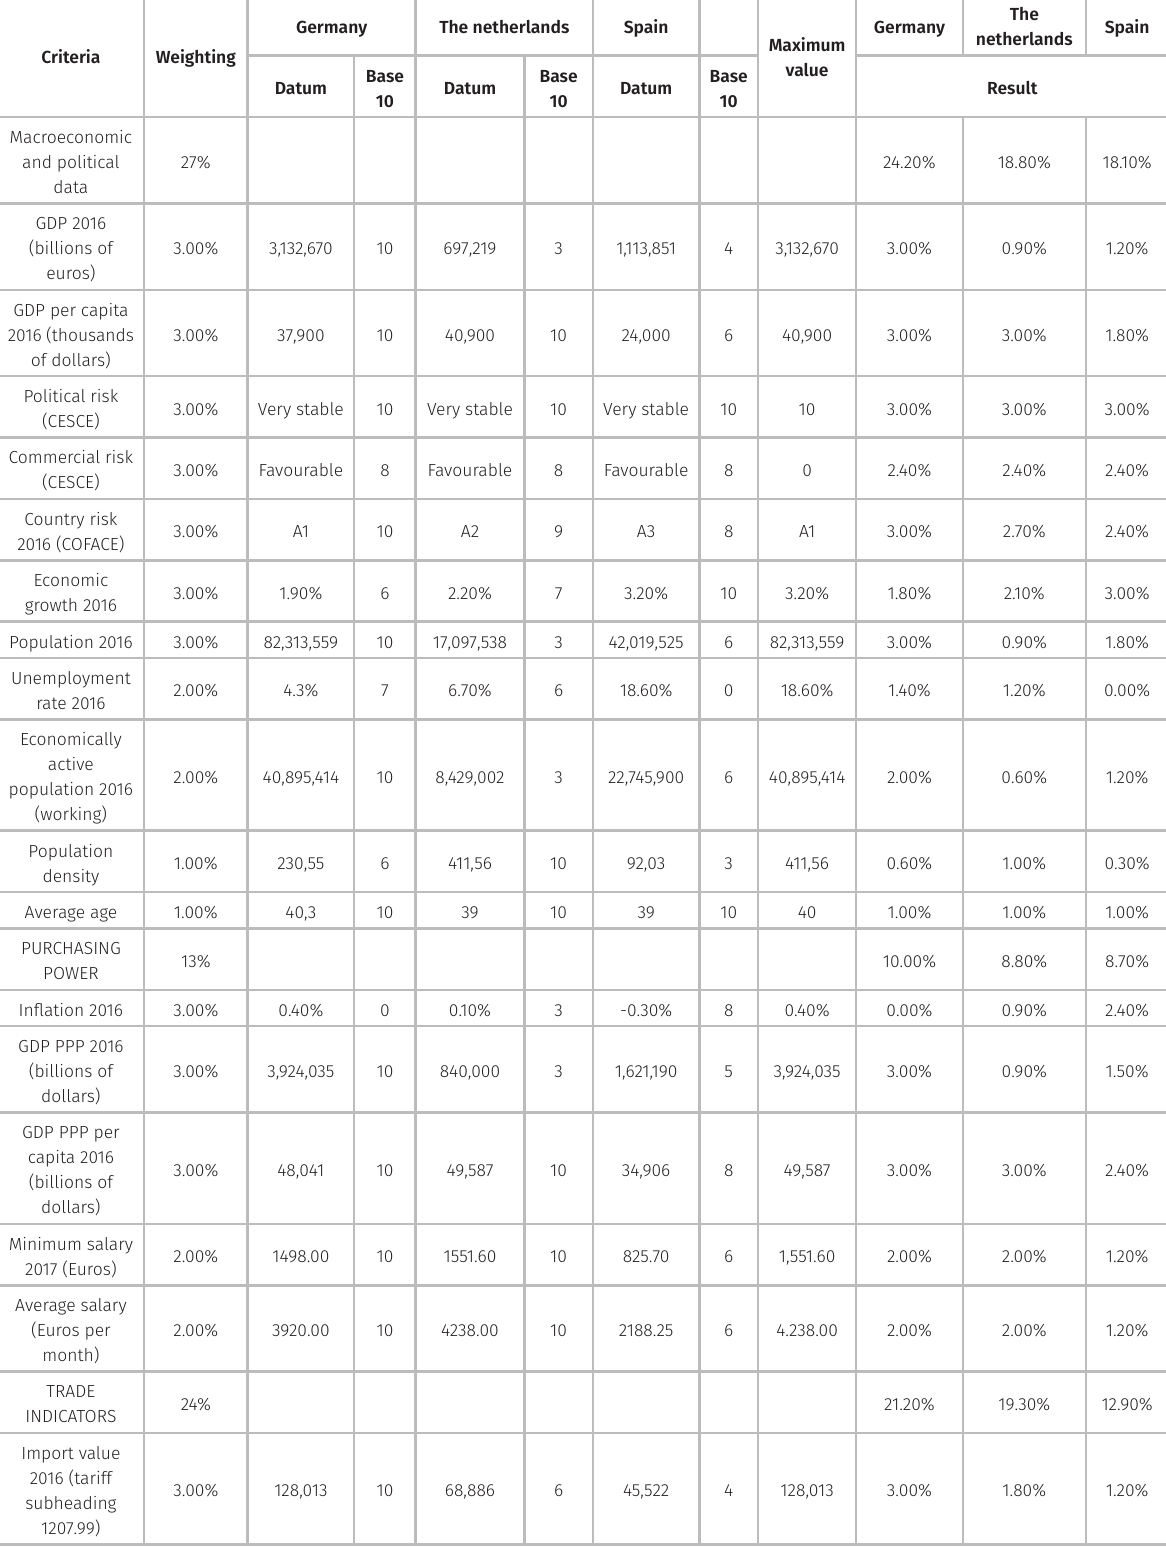
Table IX. Target market selection for the export of Ecuadorian chia seeds.